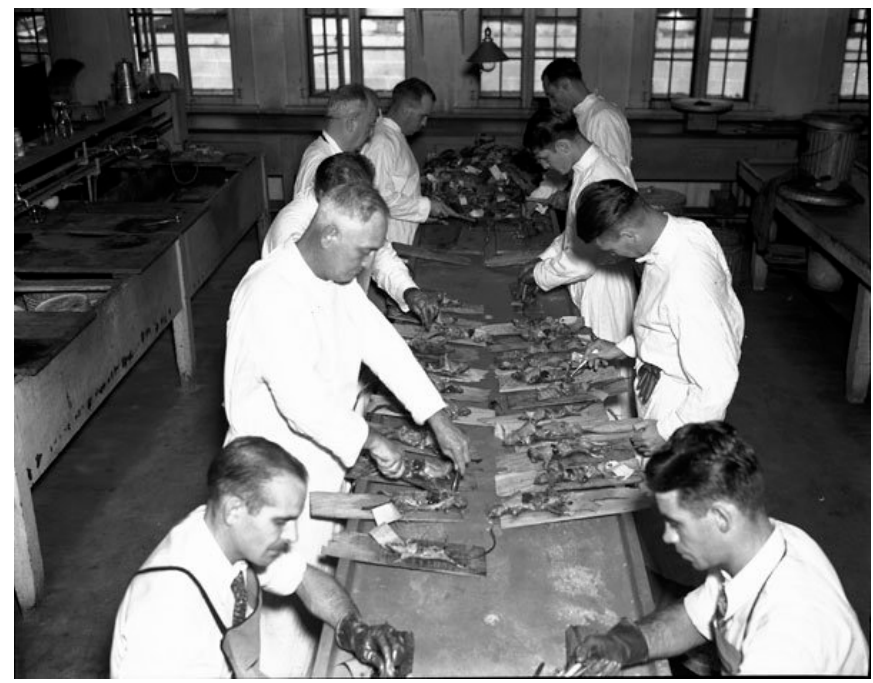
Figure 6. Works Progress Administration workers nailing rats to shingles for inspection, New Orleans, 1936.